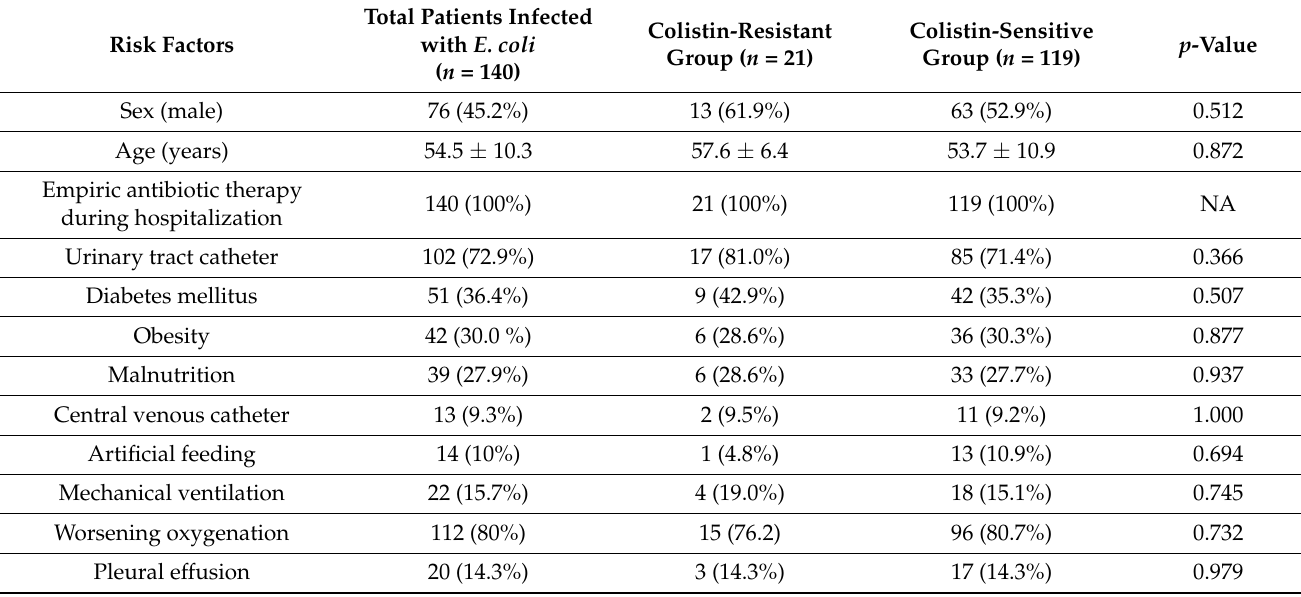
Table 2. Baseline characteristics of the patients admitted to the chest intensive care unit (ICU) with pneumonia.